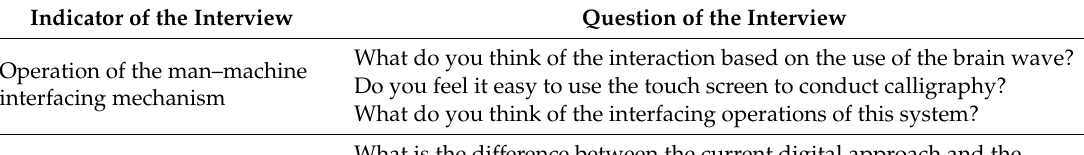
Table 7. List of the questions used in the interviews with the writers using the proposed system. Indicator of the Interview Question of the Interview What do you think of the interaction based on the use of the brain wave? Operation of the man–machine Do you feel it easy to use the touch screen to conduct calligraphy? interfacing mechanism What do you think of the interfacing operations of this system? What is the di ff erence between the current digital approach and the Opinion on the calligraphy traditional approach to calligraphy? procedure Can this interactive system enhance your willingness to know more about calligraphy? Opinion on the a ff ective Can you feel your emotional change based on the feedback of the system? computing process Can you feel that emotions are related to the calligraphy after you interacted with the